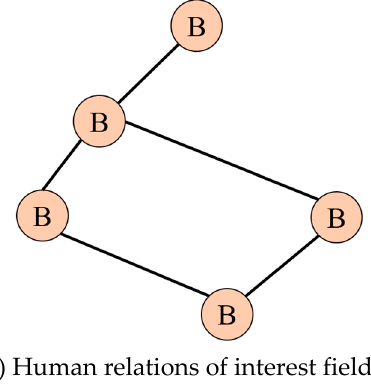
( c ) Human relations of interest field B. Figure 4. Human relation by field of interest.